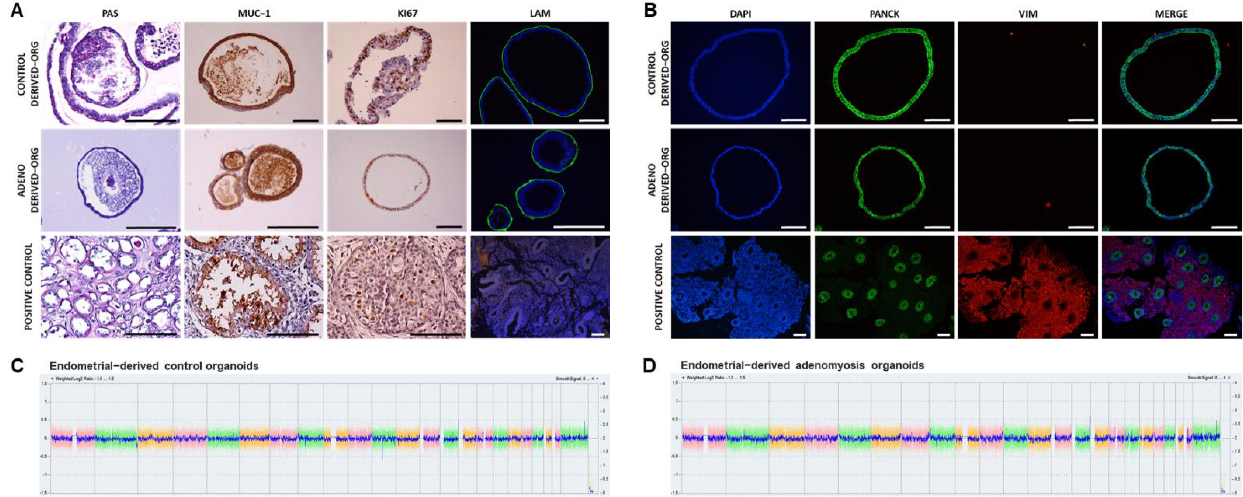
Figure 1. Characterization of glandular origin, proliferation, and epithelial polarity in human endo- metrial-derived organoids. Representative images of ( A ) PAS staining as well as MUC-1, Ki67, and laminin expression by IHC; ( B ) pan-cytokeratin and vimentin staining by IF; and chromosomal sta- bility in Control (C) and Adeno (D) derived-organoids. Scale bars are 100 µm. Kidney, endome- trium, and breast cancer samples were used as positive controls.